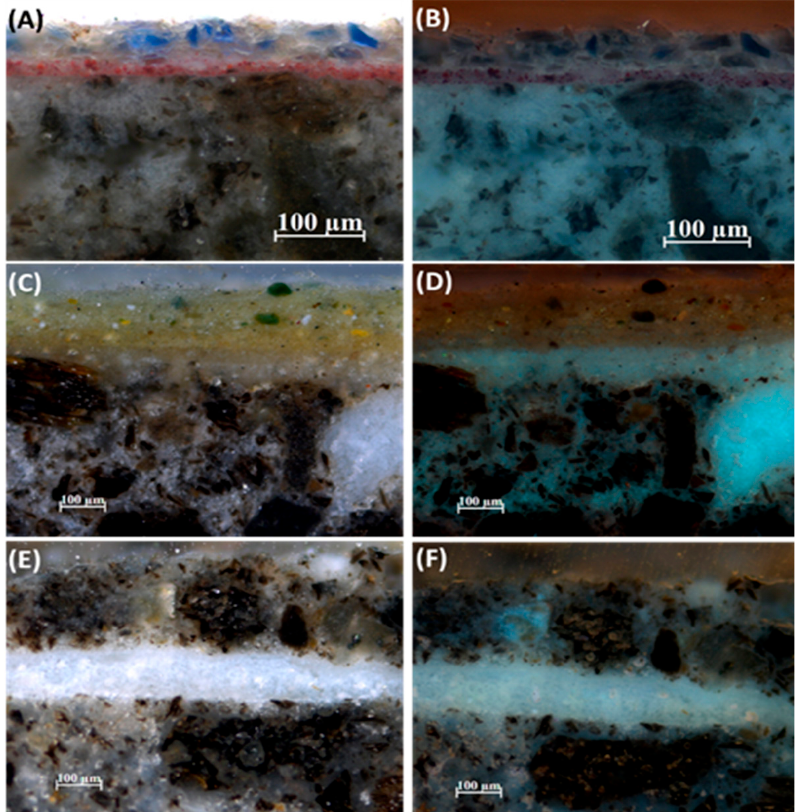
Figure 13. Microphotographs of cross-sections from the three samples. ( A , C , E ) reflected light; ( B , D , F ) ultraviolet fluorescence.